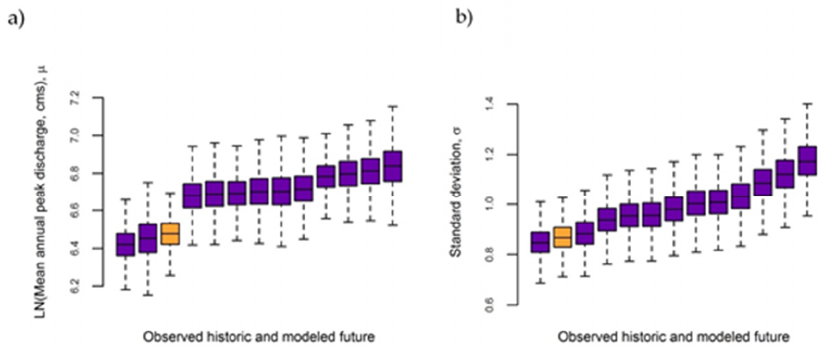
Figure 10. Posterior distribution draws for the historic data (1905–2012, orange circles) and each of the GCMs (2000–2099, purple circles). The contour lines represent the EAD threshold under Without Project conditions and the four management strategies outlined in the 2012 CVFPP. The percentage of posterior distribution draws below the threshold represents the coping range for both historic and future conditions, while the system remains vulnerable to conditions above the threshold lines.